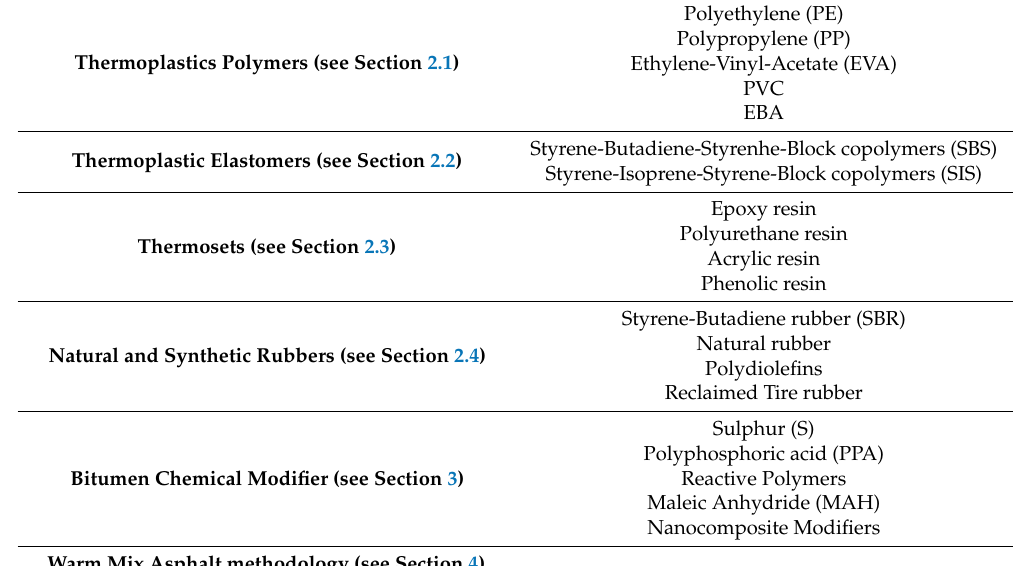
Table 2. Different categories of polymers mainly used in bitumen modification.